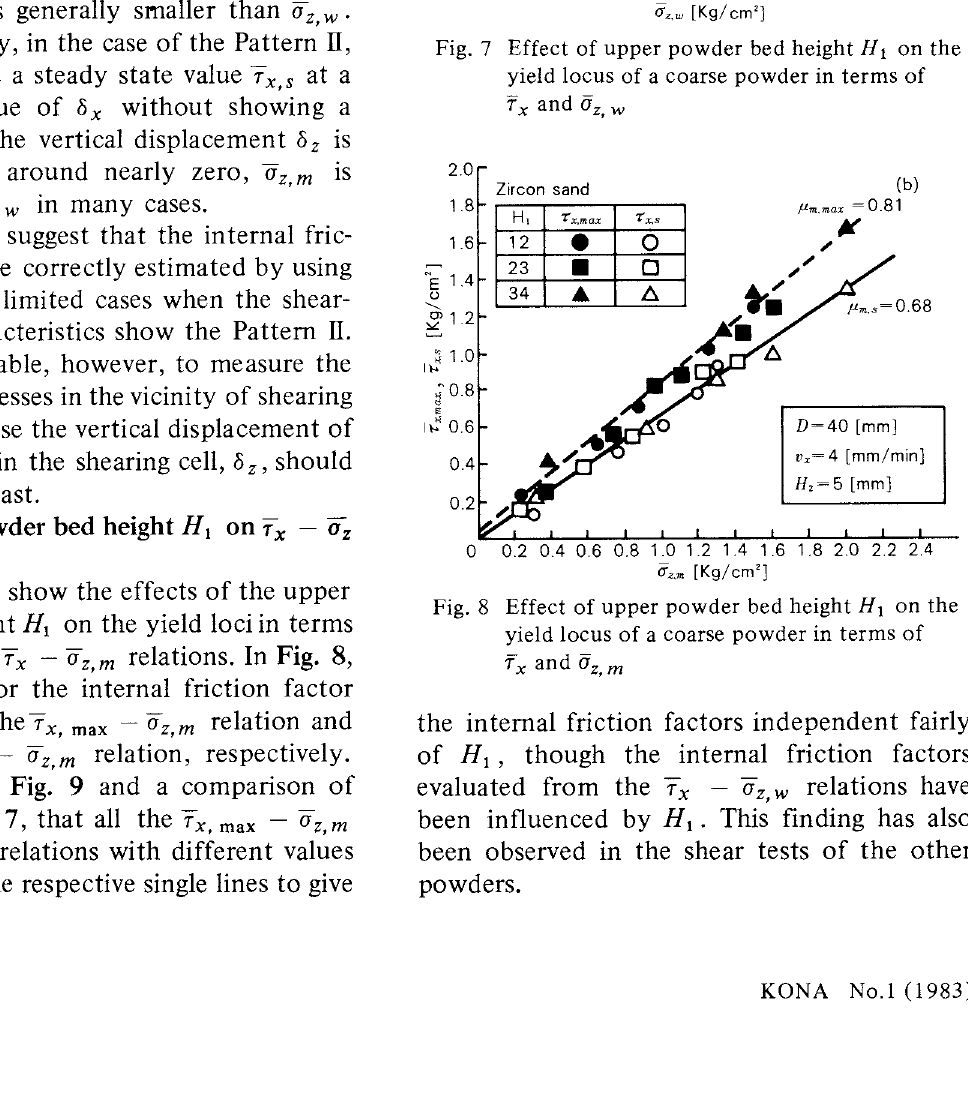
Fig. 7 Effect of upper powder bed height H 1 on the yield locus of a coarse powder in terms of